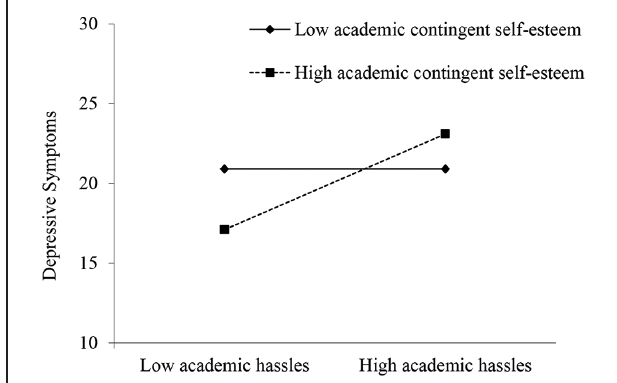
FIGURE 1 | Study 2: depressive symptoms as a function of aCSE and academic hassles. Means are plotted at 1 SD above and 1 SD below the mean of